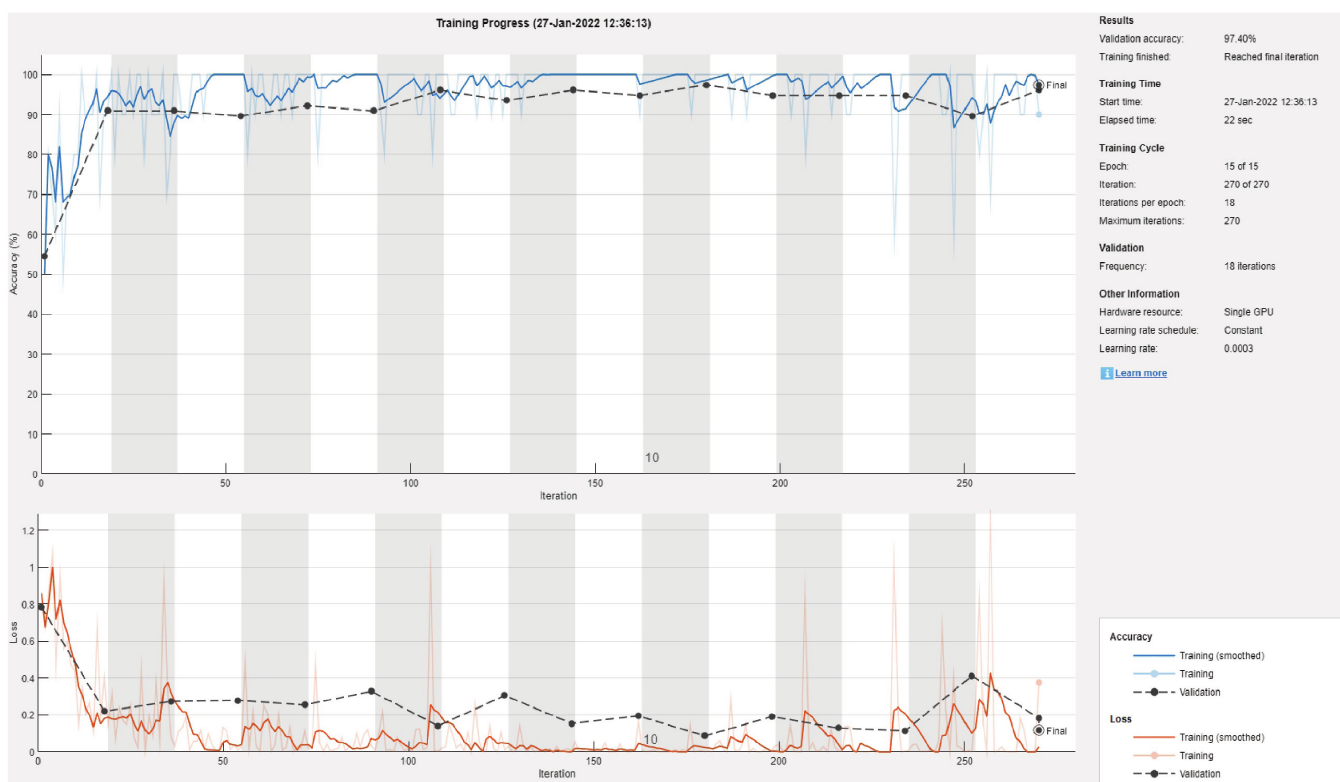
Fig 5. The RestNet-18 sample training and validation curve for normal vs scoliosis